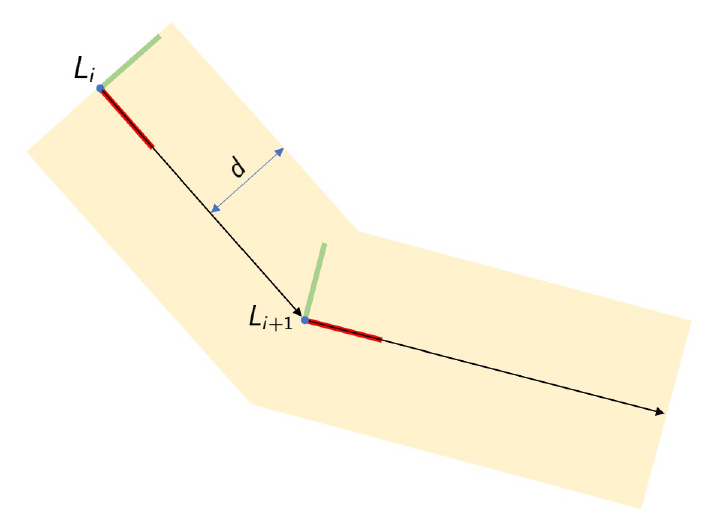
Figure 3. Calculation of path frame